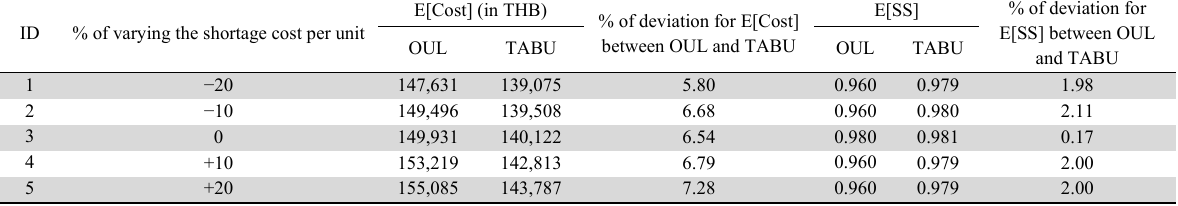
Sensitivity analysis of the efficiency of TABU for different shortage costs